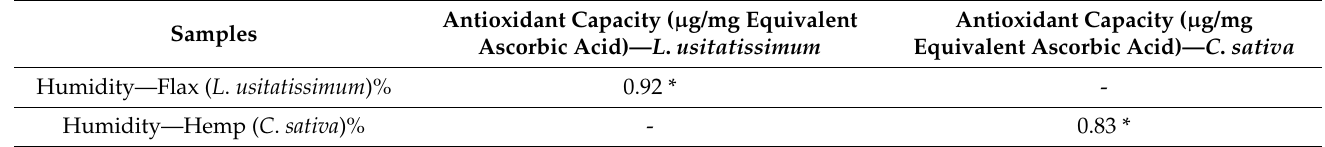
Antioxidant Capacity ( µ